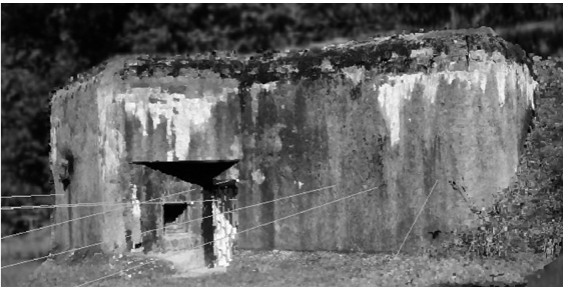
Fig. 7. MO-S 20, conversion of the triangular web to a